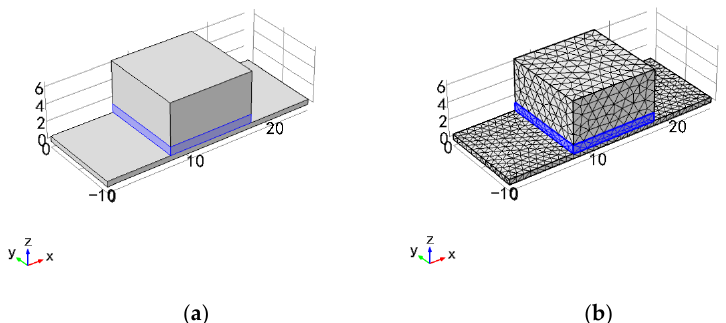
Figure 4. ( a ) The simulation model of the PE transducer; ( b ) Model meshing.